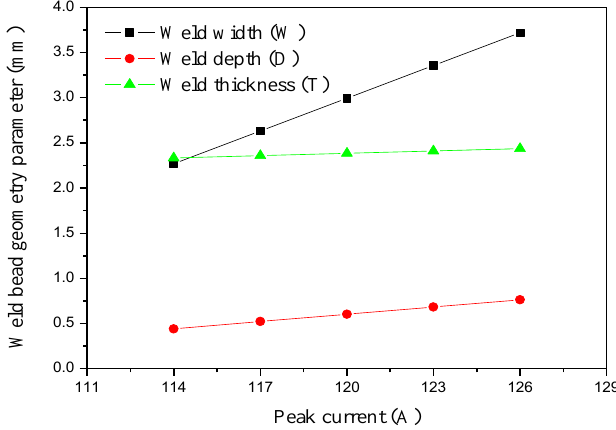
Figure 5. Influence of weld peak current on weld bead. (Welding velocity (V) = 63 mm/min, welding duty ratio (d) = 50%, welding position (P) = 90 ◦